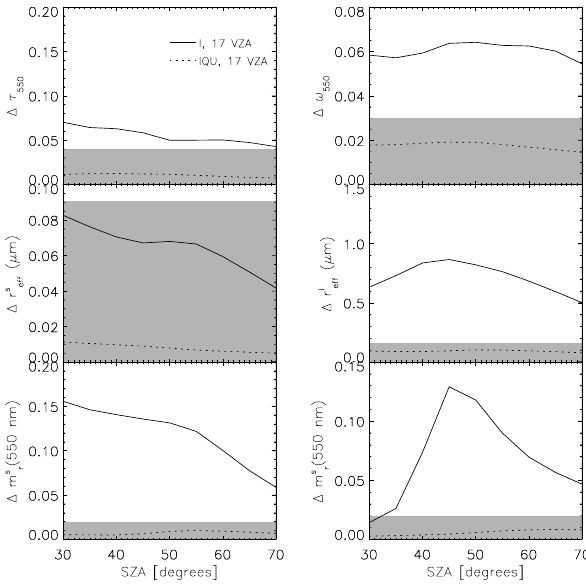
Fig. 2. Retrieval error on the aerosol optical thickness (upper left panel), single scattering albedo (upper right panel), fine mode effec- tive radius (middle left panel), coarse mode effective radius (middle right panel), fine mode real refractive index (lower left panel), and coarse mode effective radius (lower right panel), as a function of Solar Zenith Angle (SZA), for different measurements types. For these retrievals it was assumed that the surface reflection proper- ties are known. Retrieval simulations have been performed for rel- ative azimuth angle 1ϕ = 0 ◦ . For the simulations a radiometric accuracy e int = 2% and a polarimetric accuracy e pol = 0 . 002 have been used, respectively. Simulations have been performed for the European Background aerosol type (see Table 1). For the surface, the coefficients corresponding to the 2 kernels in Eq. (9) are both 1 . The Lambertian term in Eq. (9) is calculated using the albedos 2 corresponding to “deciduous” and “Gray silty clay” of the ASTER Spectral Library.